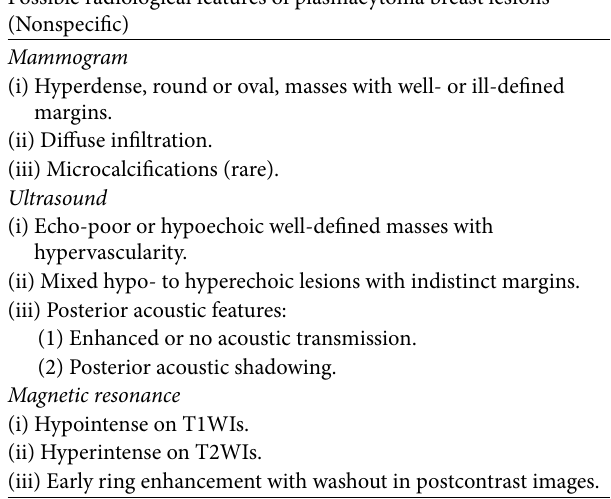
Table 1: Radiological features of plasmacytoma breast